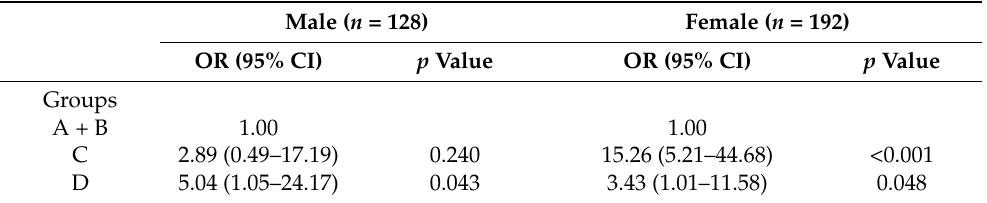
Table 7. Injection site reaction risk across the four groups, stratified by gender.